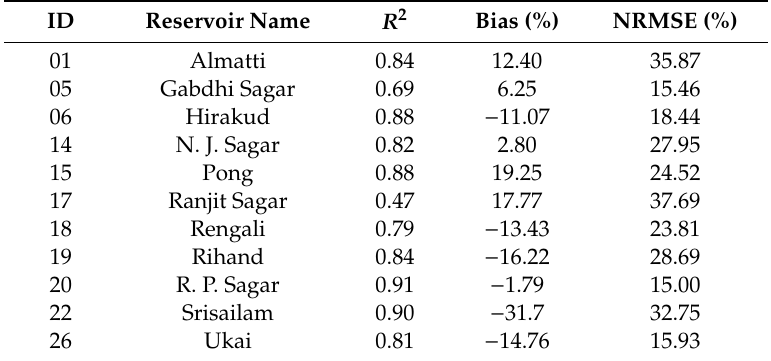
Table 2. Statistical validation results for the remotely sensed reservoir storage data obtained from the MODIS-SRTM